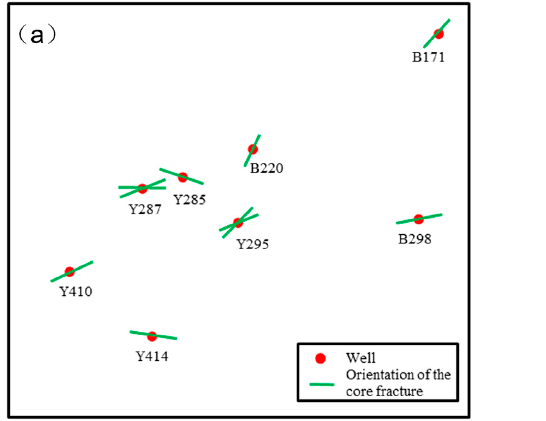
Figure 5. Histogram of core fracture density.